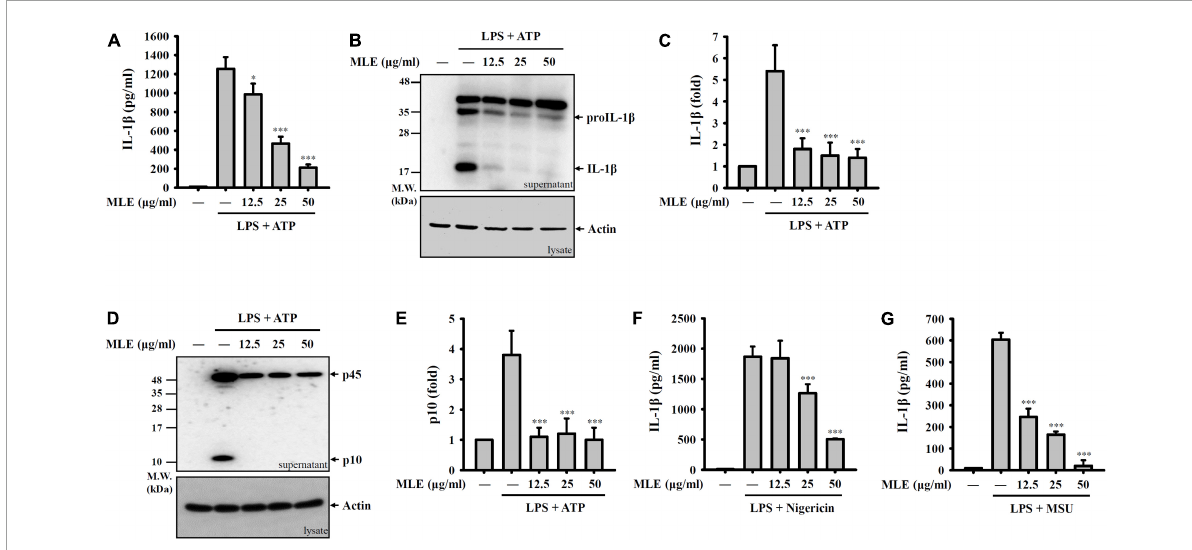
FIGURE1 MLE inhibits the NLRP3 inflammasome. (A–E) LPS-primed J774A.1 macrophages were incubated with MEL for 0.5 h before ATP stimulation for an additional 0.5 h. The levels of IL-1 β in the supernatants were analyzed by ELISA (A) and western blot (B) . (C) The column diagram represents the fold change of IL-1 β in (B) compared with the control group analyzed by ImageJ. (D) The levels of pro-caspase-1 (p45) and active caspase-1 (p10) in the supernatants were analyzed by western blot. (E) The column diagram represents the fold change of p10 in (D) compared with the control group analyzed by ImageJ. (F,G) LPS-primed J774A.1 macrophages were incubated with MEL for 0.5 h before nigericin stimulation for an additional 0.5 h (F) or MSU stimulation for an additional 24 h (G) . The levels of IL-1 β in the supernatants were analyzed by ELISA. The western blot images are representative of three different experiments. The data are expressed as the mean ± SD of three separate experiments. * p < 0.05 and *** p < 0.001 compared to NLRP3 inflammasome-activated cells.